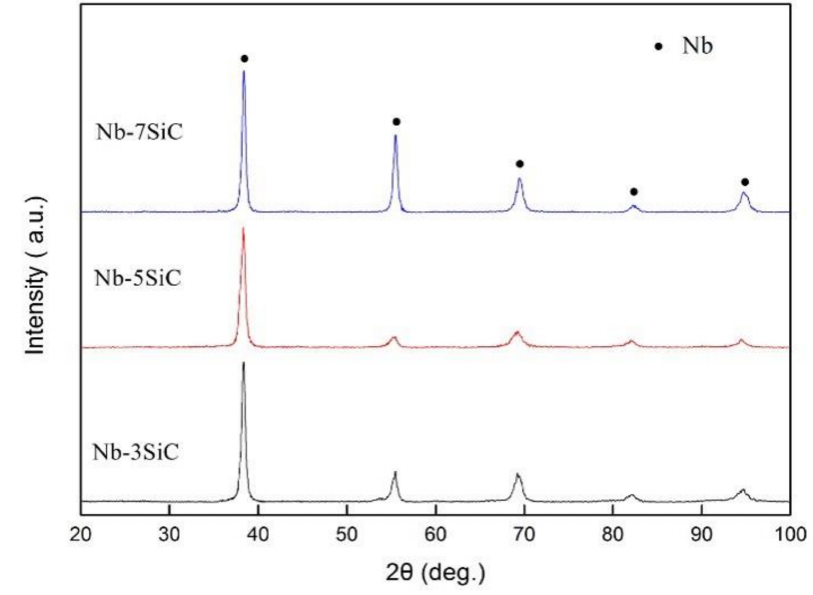
Figure 4. XRD patterns of composite powders after milling for 25